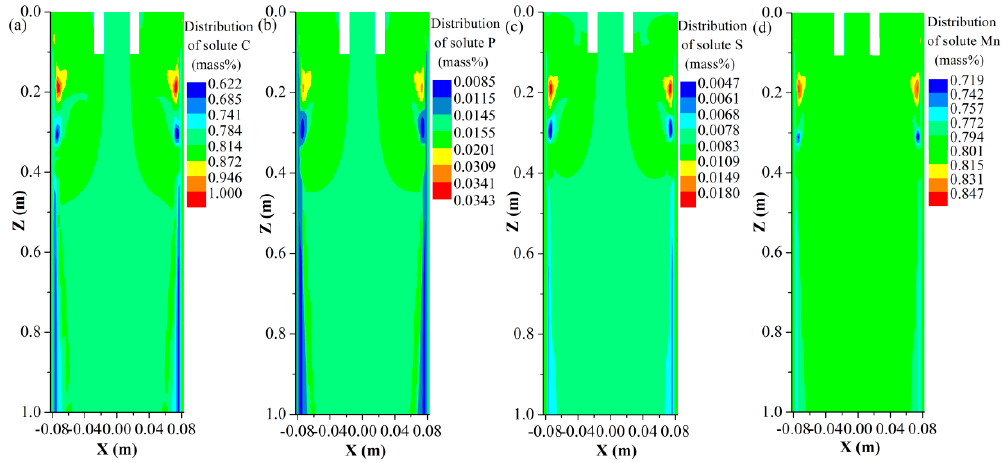
Figure 7. Distribution of different solute elements in the mold: ( a ) C; ( b ) P; ( c ) S; and ( d ) Mn. Metals 2017 , 7 , 209